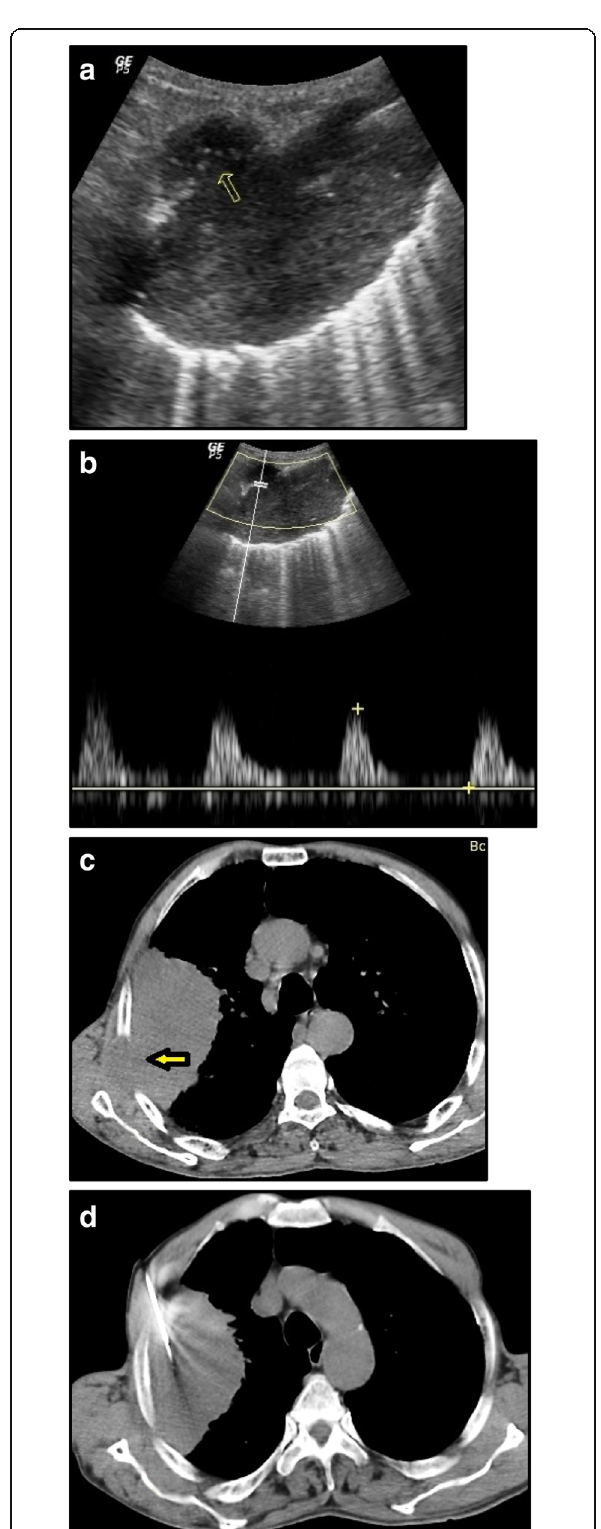
Fig. 4 US images show a well-defined isoechoic soft tissue mass lesion measuring 10 × 6 cm ( a ) showing chest wall invasion (yellow arrow). Doppler study shows extended intralesional vascularity in the chest wall ( b ). Non-enhanced CT shows right-sided peripheral lung mass ( c ) with chest wall extension (yellow arrow). CT-guided biopsy was taken ( d ). Histopathology revealed